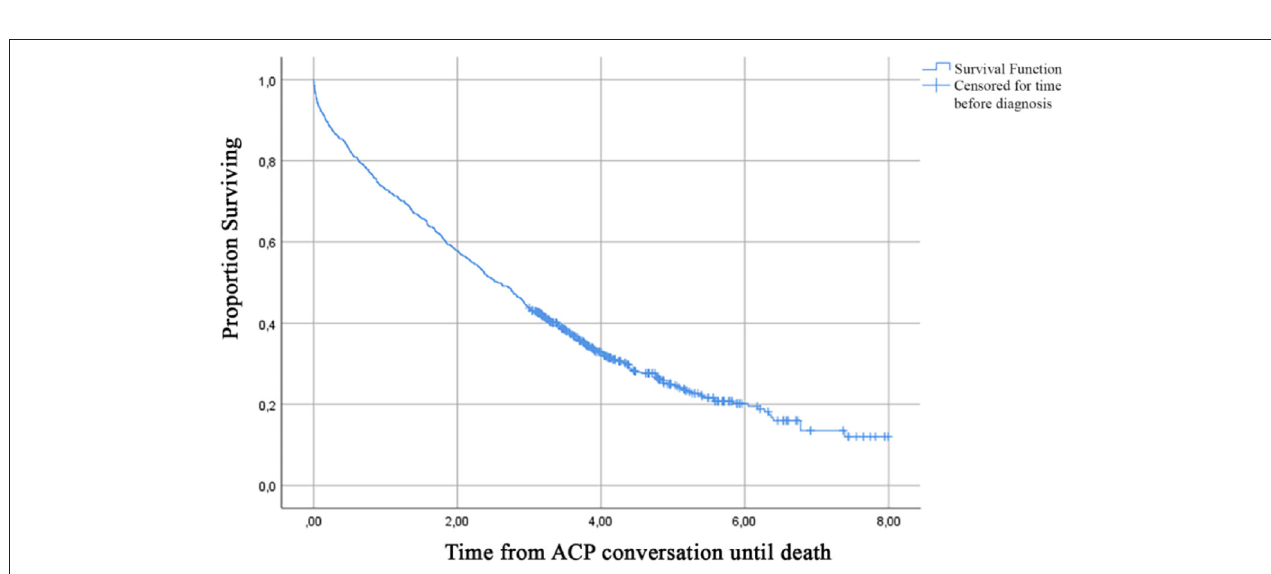
FIGURE 2 | Cumulative incidence curve of a first recorded ACP conversation until 8 years after dementia diagnosis.